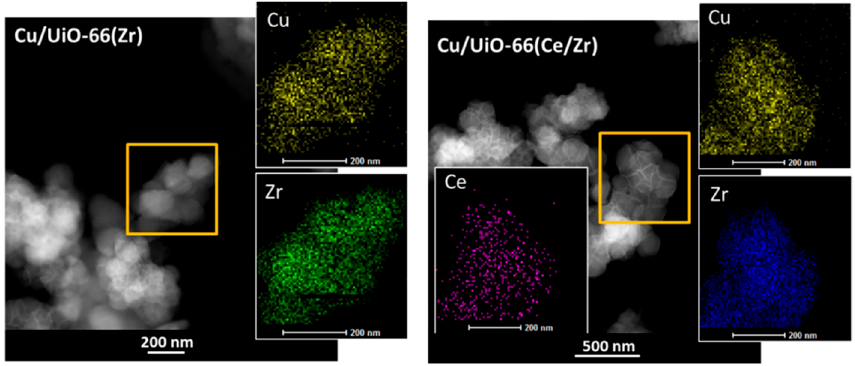
Figure 6. HAADF-STEM images of Cu / UiO-66(Zr), with marked area of Cu and Zr EDS maps (left) and Cu / UiO-66(Ce / Zr), Cu, Ce and Zr EDS maps (right).